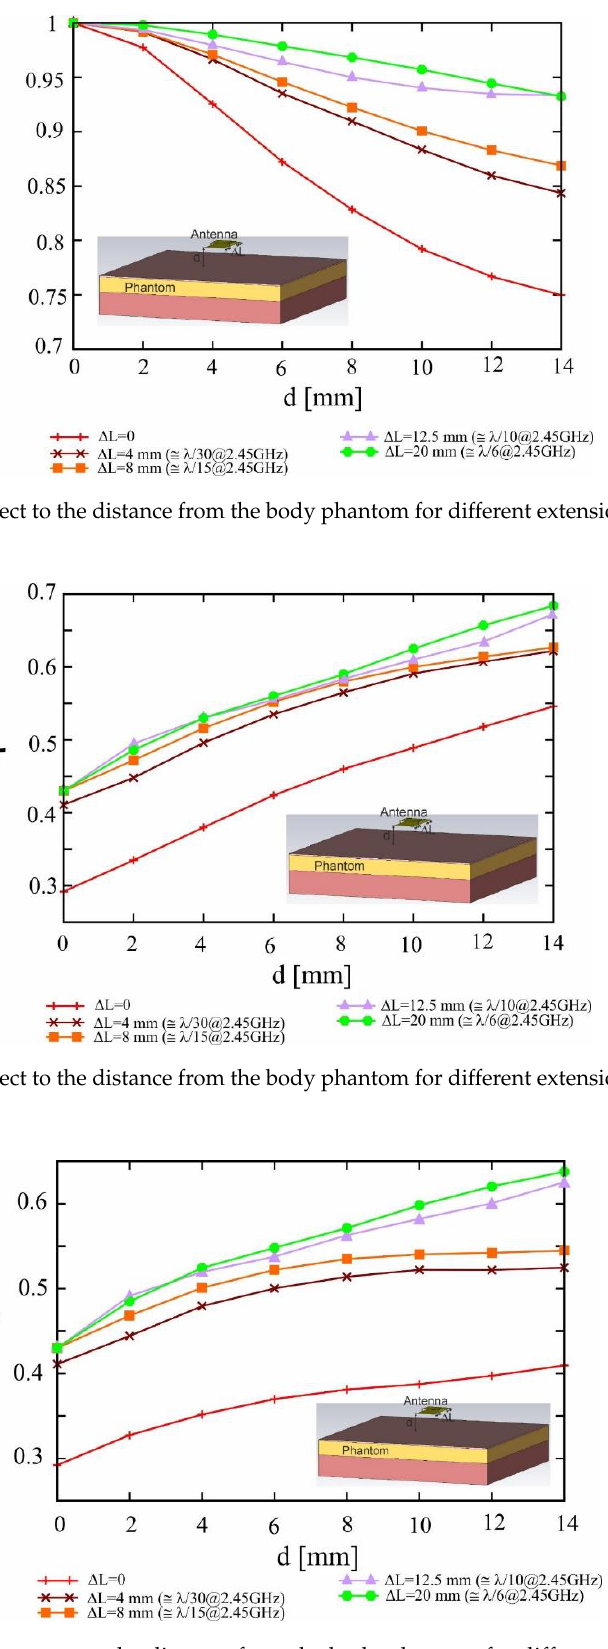
Figure 16. τ × η with respect to the distance from the body phantom for different extensions of the Figure 16.  ×  with respect to the distance from the body phantom for different extensions of the antenna ground Figure 16.  ×  with respect to the distance from the body phantom for different extensions of the antenna ground plane. Figure 16.  ×  with respect to the distance from the body phantom for different extensions of the antenna ground plane. antenna ground plane.